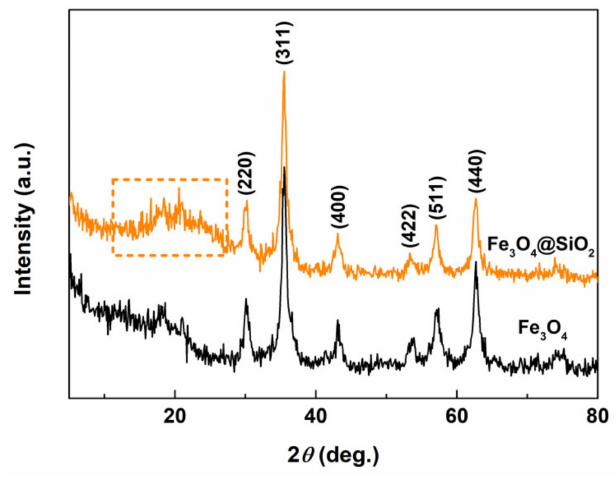
Figure 2. XRD patterns of Fe 3 O 4 and Fe 3 O 4 @SiO 2